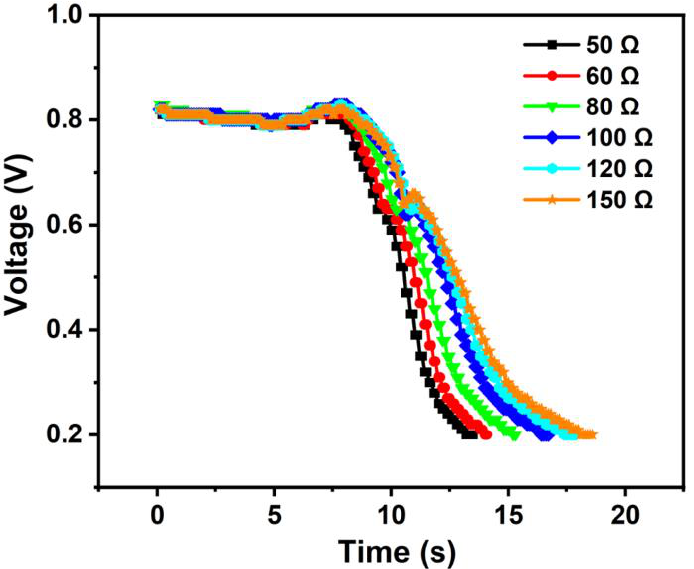
Figure 7. Influence of the different auxiliary load resistance on the PEMFC shutdown process.